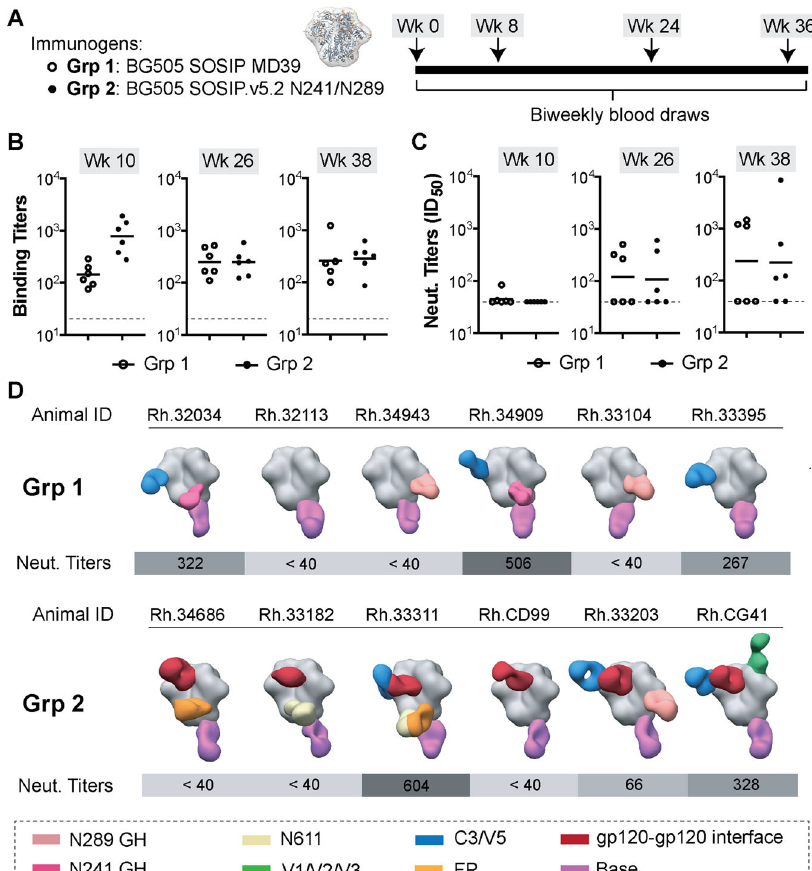
Fig. 1 Immunization experiments with the stabilized BG505 SOSIP trimers. A Immunogen (left) and immunization schedule (right). B ELISA binding titers (midpoint) and C neutralizing antibody titers (ID 50 ) for plasma samples collected at weeks 10, 26, and 38 (time points indicated above each graph; open circles — Grp 1; closed circles — Grp 2). Horizontal lines represent the geometric mean values at each time point ( n = 6 animals in each group). ELISA and pseudovirus neutralization experiments were performed in triplicates ( n = 3) for each serum sample at every time point and the mean value is plotted. D Composite fi gures from nsEMPEM analysis of polyclonal responses at week 26. Animal IDs and neutralizing antibody titers (at week 26) for corresponding animals are shown above and below each composite fi gure, respectively. A color-coding scheme for antibodies targeting different epitope clusters is shown at the bottom. BG505 SOSIP antigen is represented in